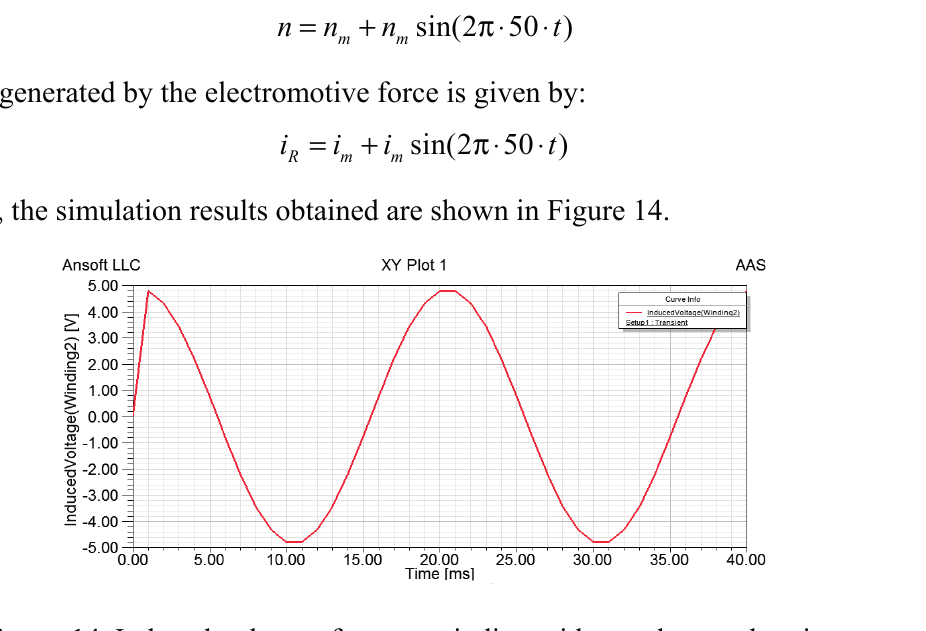
Figure 14. Induced voltage of output winding with angular